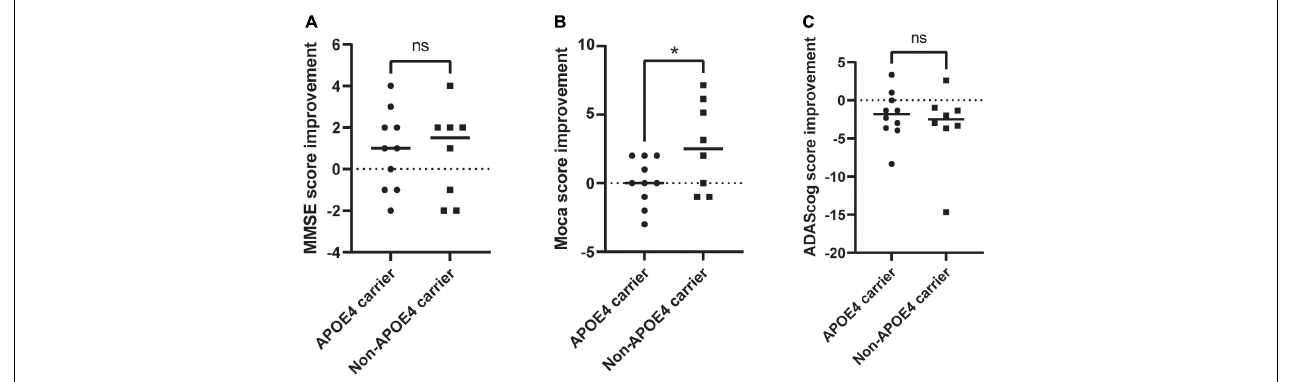
FIGURE 2 | Evaluation of the changes in neuropsychological scale of APOE4 carries and noncarriers pre-rTMS and post-rTMS. (A) MMSE improvement; (B) MoCA improvement; (C) ADAScog improvement. rTMS, repetitive transcranial magnetic stimulation; MoCA, Montreal Cognitive Assessment Scale; ADAScog, Assessment Scale-cognitive subscale. ∗ Indicates of a P -value <